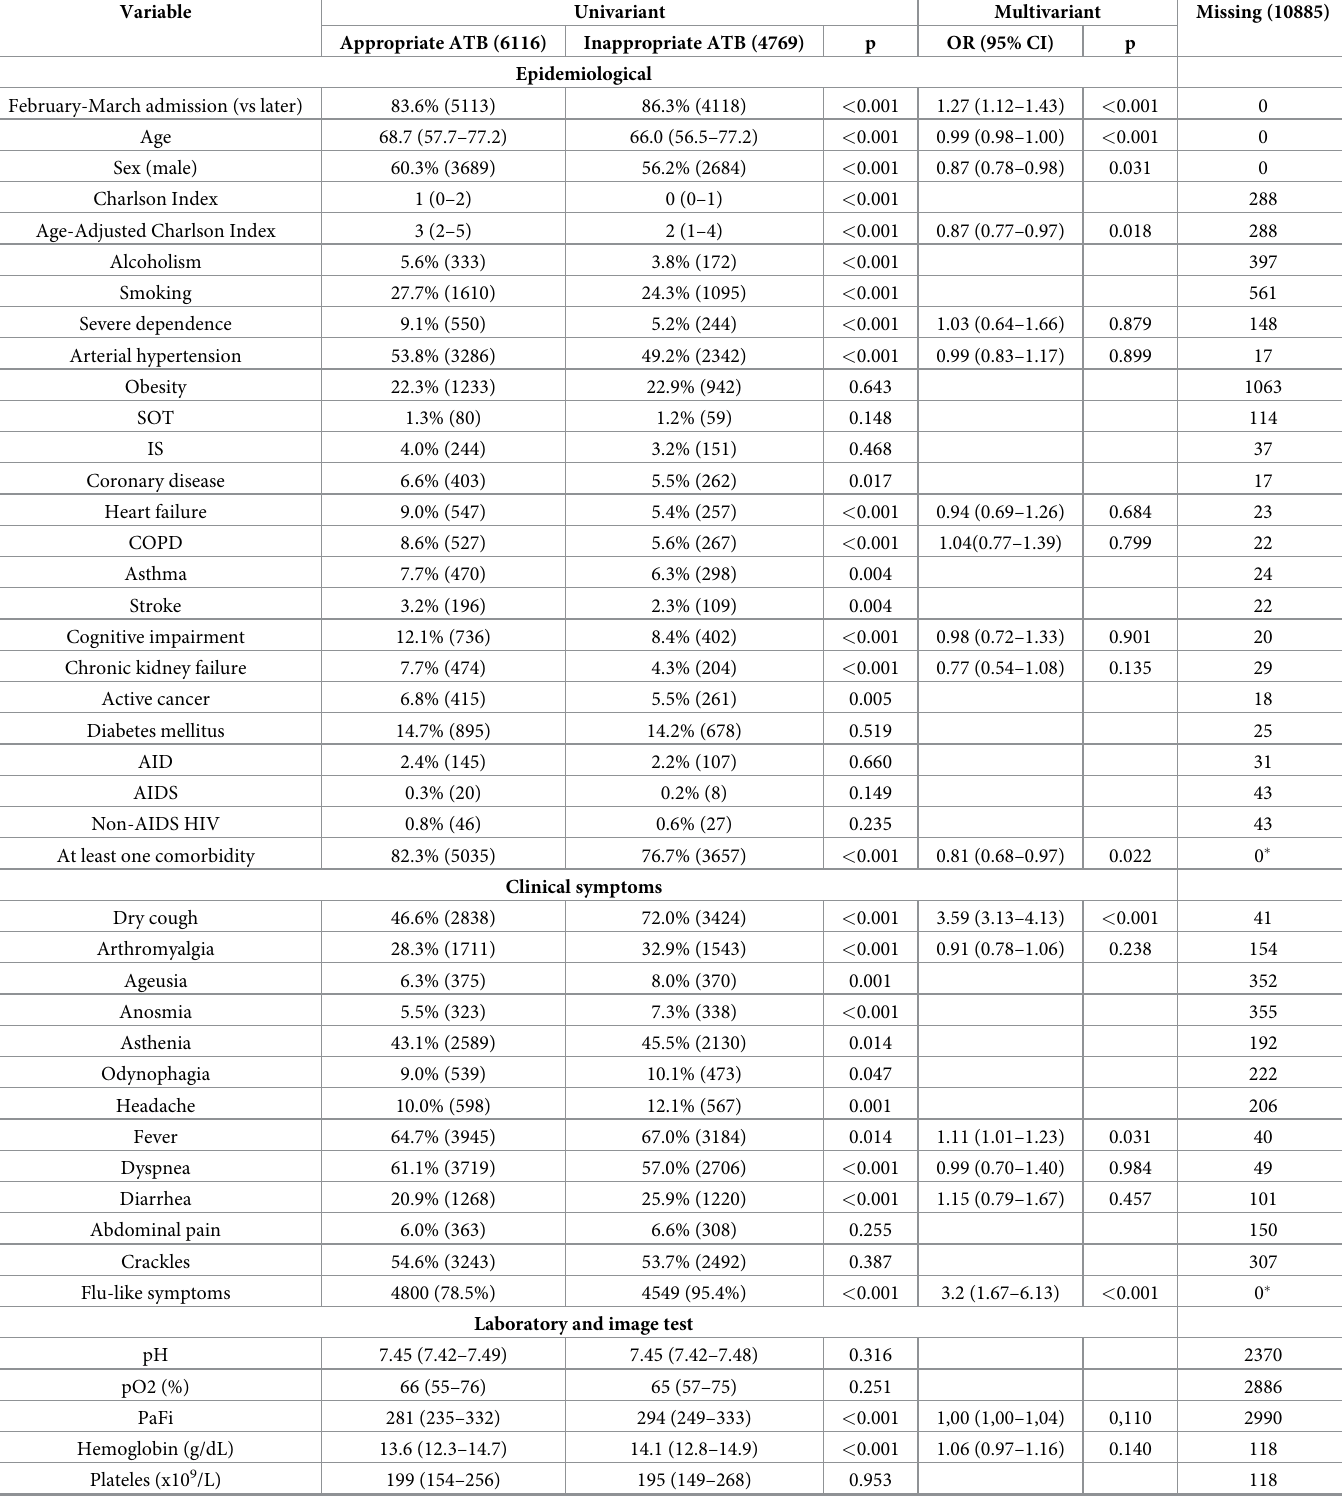
Table 2. Epidemiological, clinical and analytical characteristics according to the appropriate or inappropriate prescription of